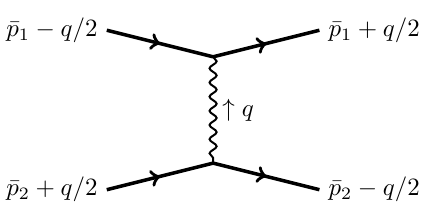
Figure 7. Kinematic setup with special